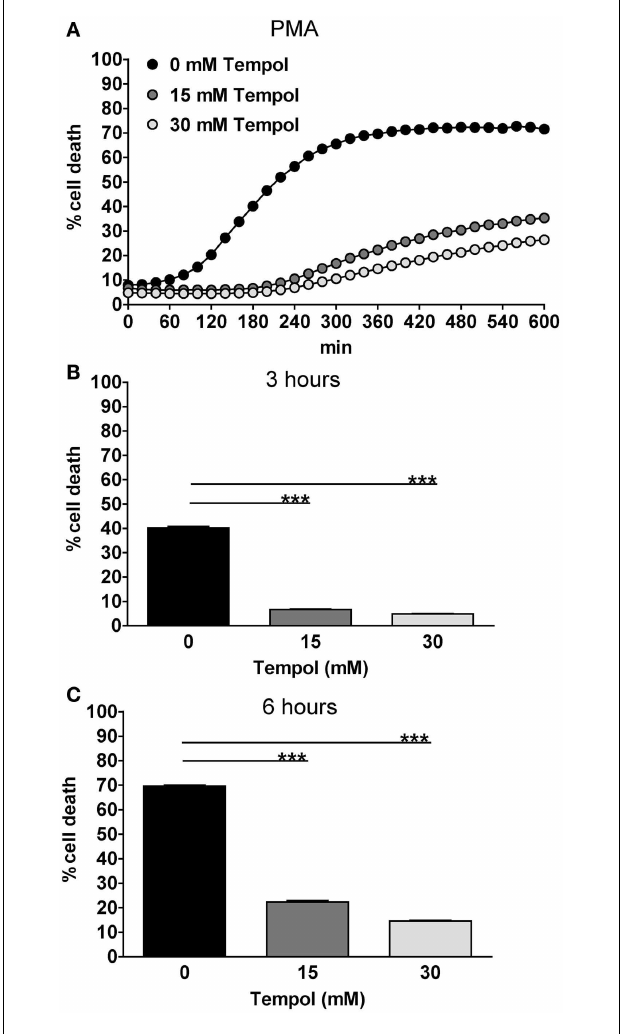
FIGURE 4 |Tempol prevents PMA-induced NET formation quantified by cell death assay. Tempol reduces PMN cell death in a dose-dependent manner.The rate of cell death of PMNs stimulated with the highly potent NET-inducer PMA in the presence or absence ofTempol was analyzed over a period of 10h by measurement of DNA-staining by the cell-impermeable dye Sytox Green. (A) The Y -axis represents the relative amount of dead cells after normalization to the lysis control (100%). Background values (unstimulated cells) were subtracted from all values.To allow better comparison with microscopic analyses, the effect ofTempol on PMA-induced PMN cell death after stimulation for 3h (B) and 6h (C) is additionally depicted as bar panels. (A) Black curve: PMNs stimulated with 100nM PMA withoutTempol treatment, gray curves: PMNs treated with different concentrations ofTempol prior to stimulation with PMA. Significance was analyzed byTukey one-way ANOVA *** P ≤ 0.001). One representative experiment out of three independent experiments with three different donors is shown. Data are presented as means of three technical replicates ±